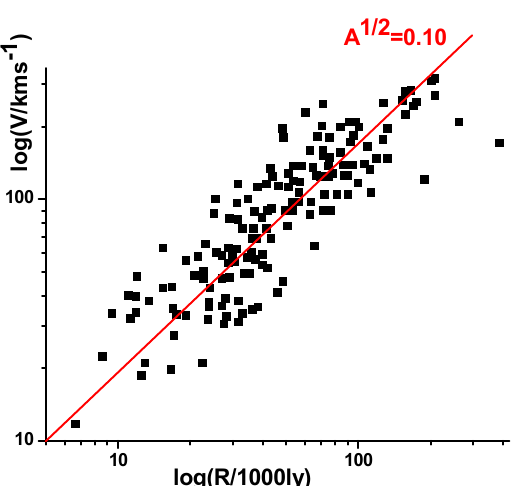
Figure 2. Log–log plot of the observed circular velocity V as a function of the maximum radius R for low-redshift disk galaxies re-plotted using data from Figure 4 of Ref. [7]. Low scatter around the “universal slope” 1.84 × 10 − 3 km / s / ly indicated by the red line implies that this relationship is generic for disc galaxies in the low-redshift universe. As a result, the galaxies behave as “cosmic clocks”, rotating roughly once a billion years at the very outskirts of their discs. This “universal slope” corresponds to A 1 / 2 ~0.10.